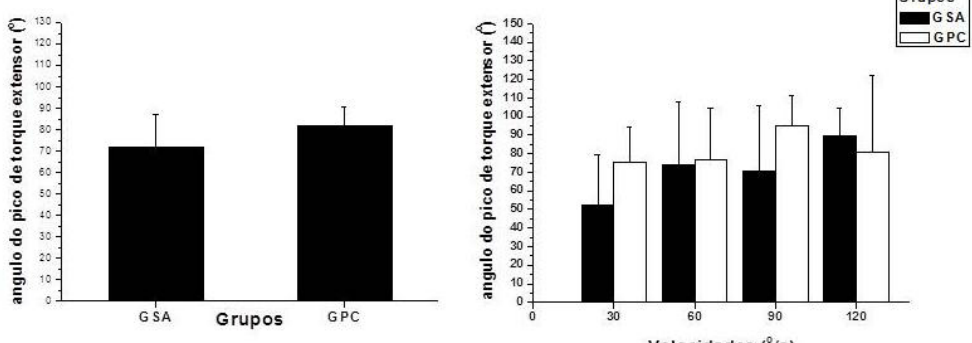
Figura 3. Média e desvio padrão do ângulo do pico de torque extensor de cotovelo nos grupos GSA e GPC e